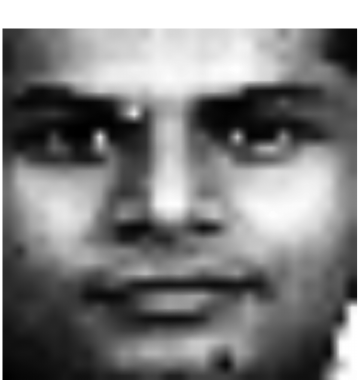
Figure 3: Sample Patient Face